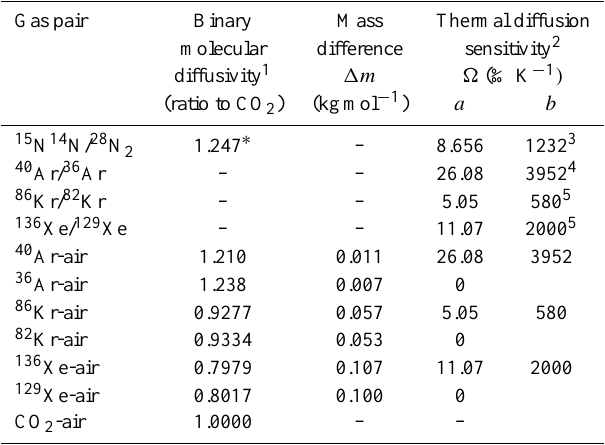
Table 3. Gas parameters used in numerical model runs. Gas pair Binary Mass Thermal